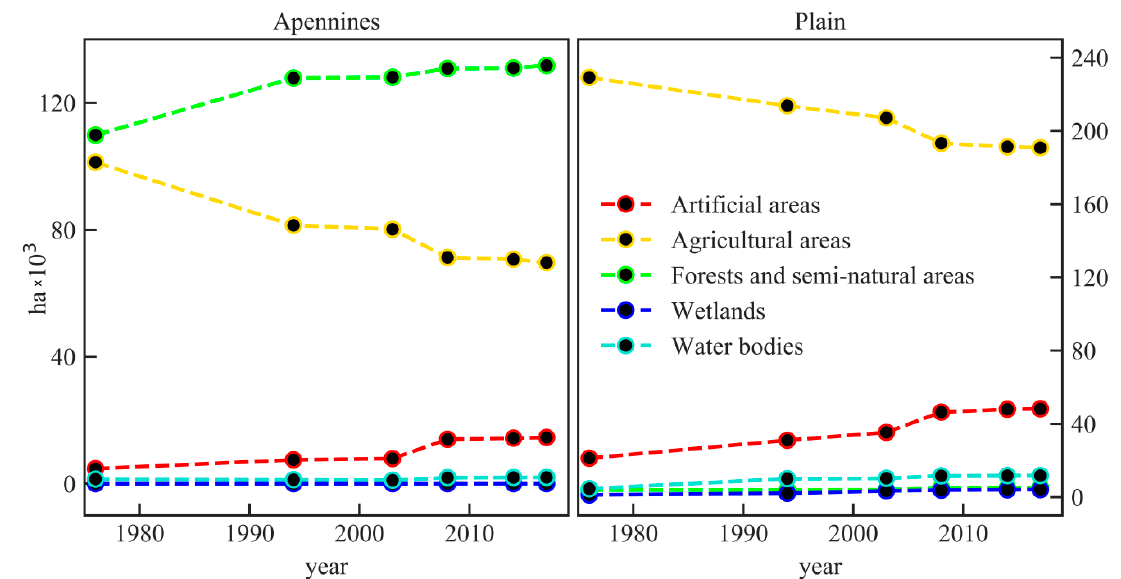
Figure 6. Land use changes (in hectares) within the Reno and Lamone river basins since 1976, for the Apennines ( left panel ) and alluvial plain ( right panel ).